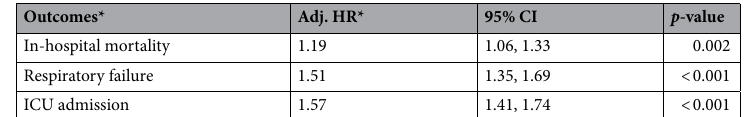
Table 3. Association of history of diabetes to the different outcomes of interest. *Individual univariate multiple logistic regression analysis with independent variable diabetes adjusted for age group, sex, smoking history, hypertension, chronic cardiac disease, chronic kidney disease, chronic respiratory disease, chronic neurologic disease, chronic liver disease, and HIV/AIDS.